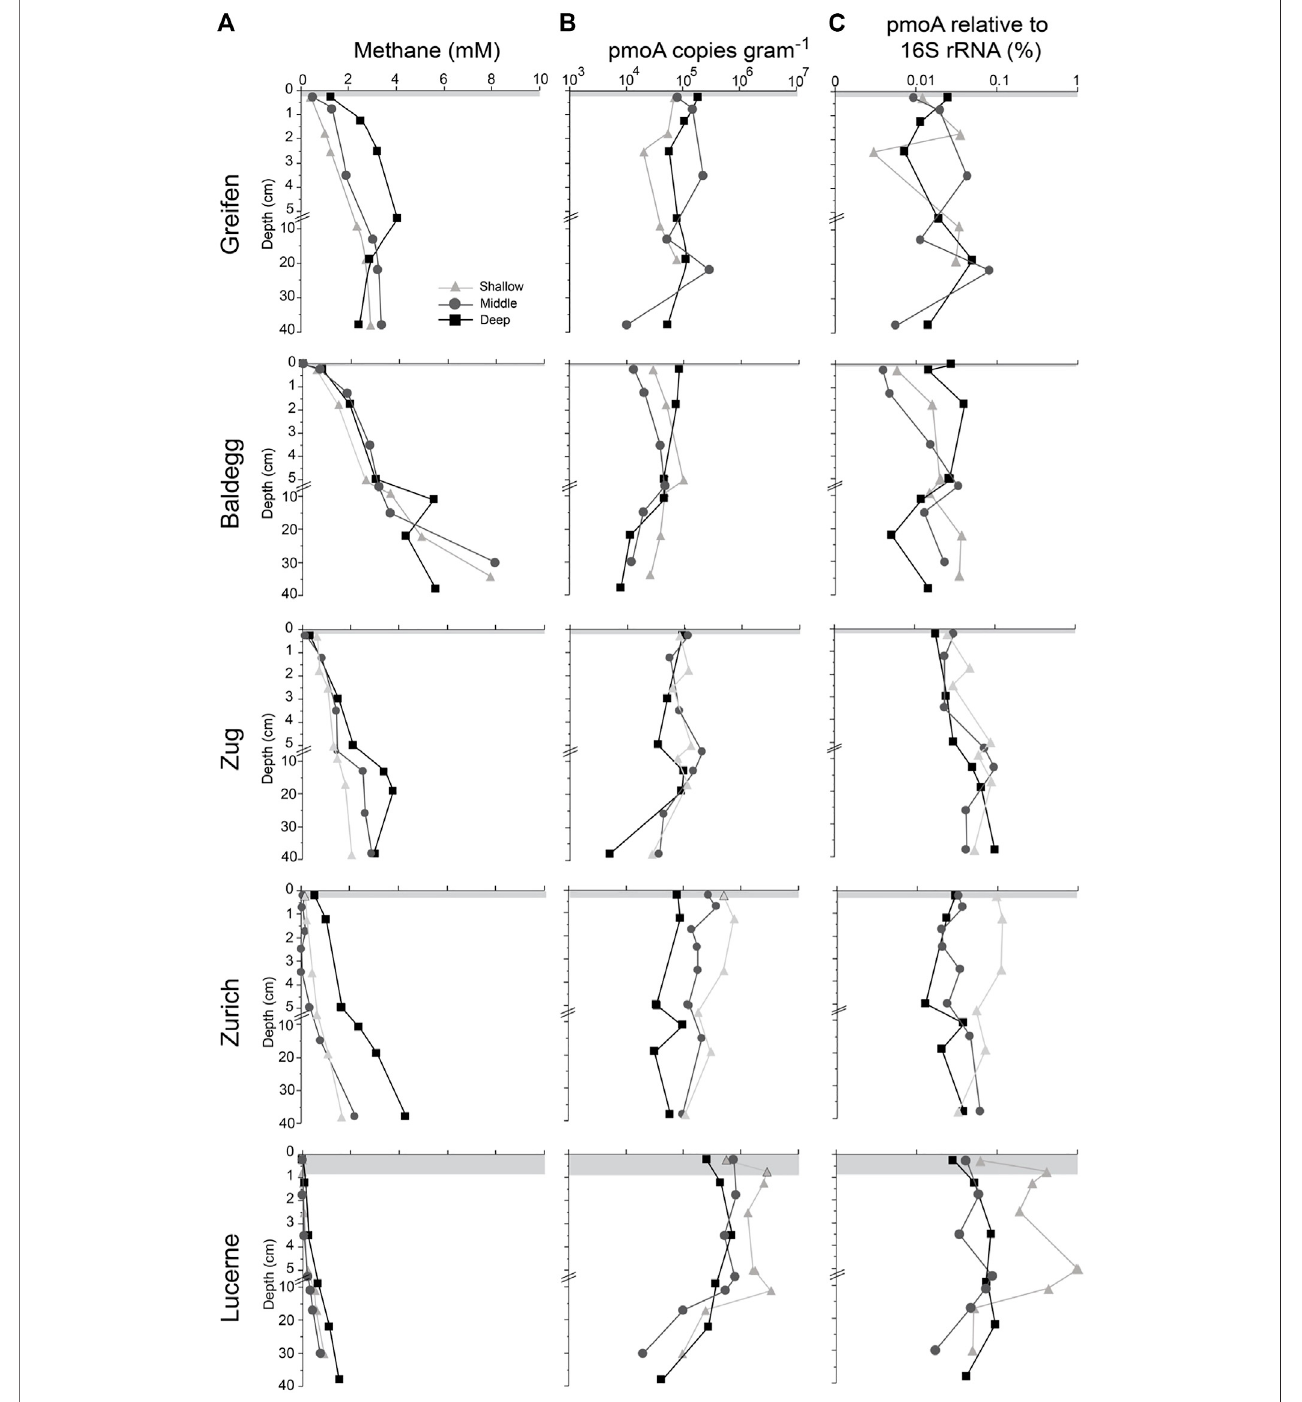
FIGURE 1 | Methane, O 2 and MOB dynamics in sediments of the three lakes. (A) methane concentrations pro fi les and depth of O 2 penetration (gray area below sediment surface). (B) Absolute abundances of pmoA asdetermined by qPCR. (C) Relative contribution ofMOB tothe total microbial community, estimated from ratios of pmoA to total 16S rRNA gene copies. Note the log-scale in (B) and (C).